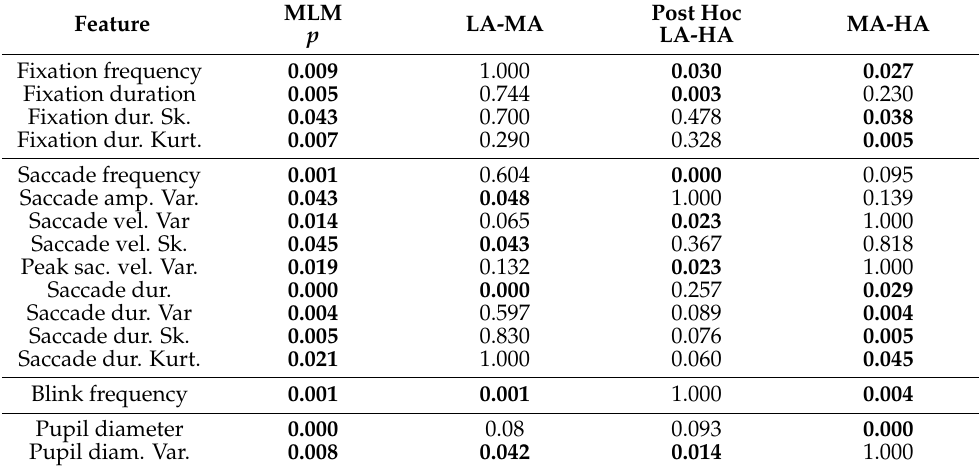
Table 6. Results of Mixed Linear Model (MLM) and post hoc tests for arousal levels.